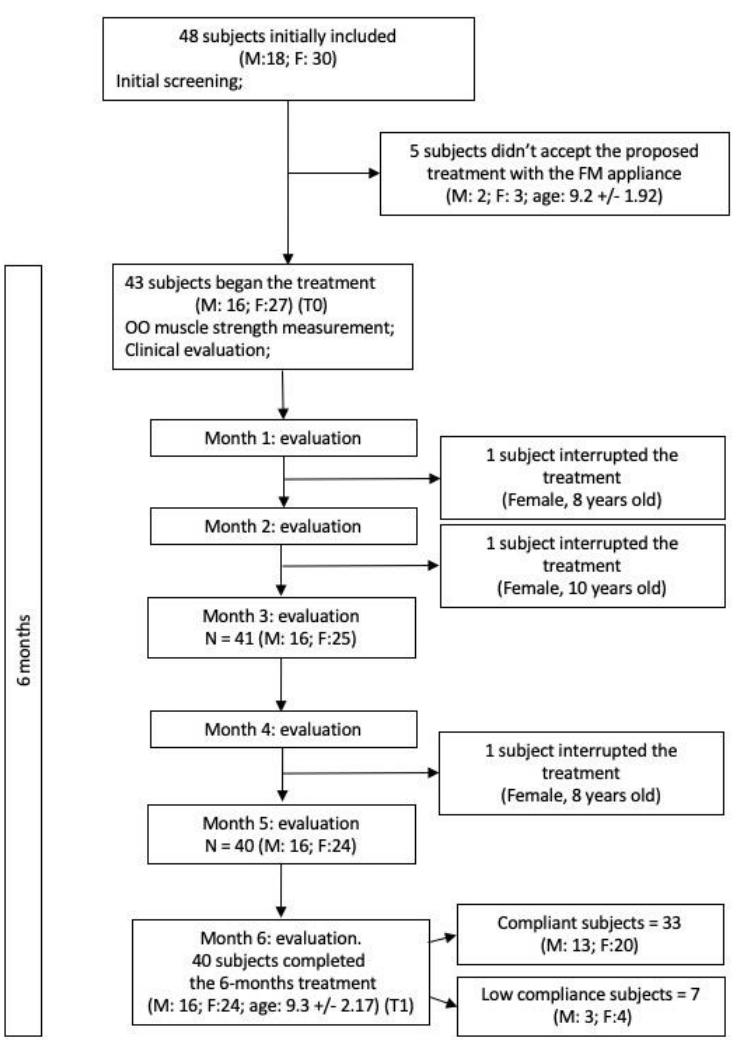
Figure 2. Study flow chart.